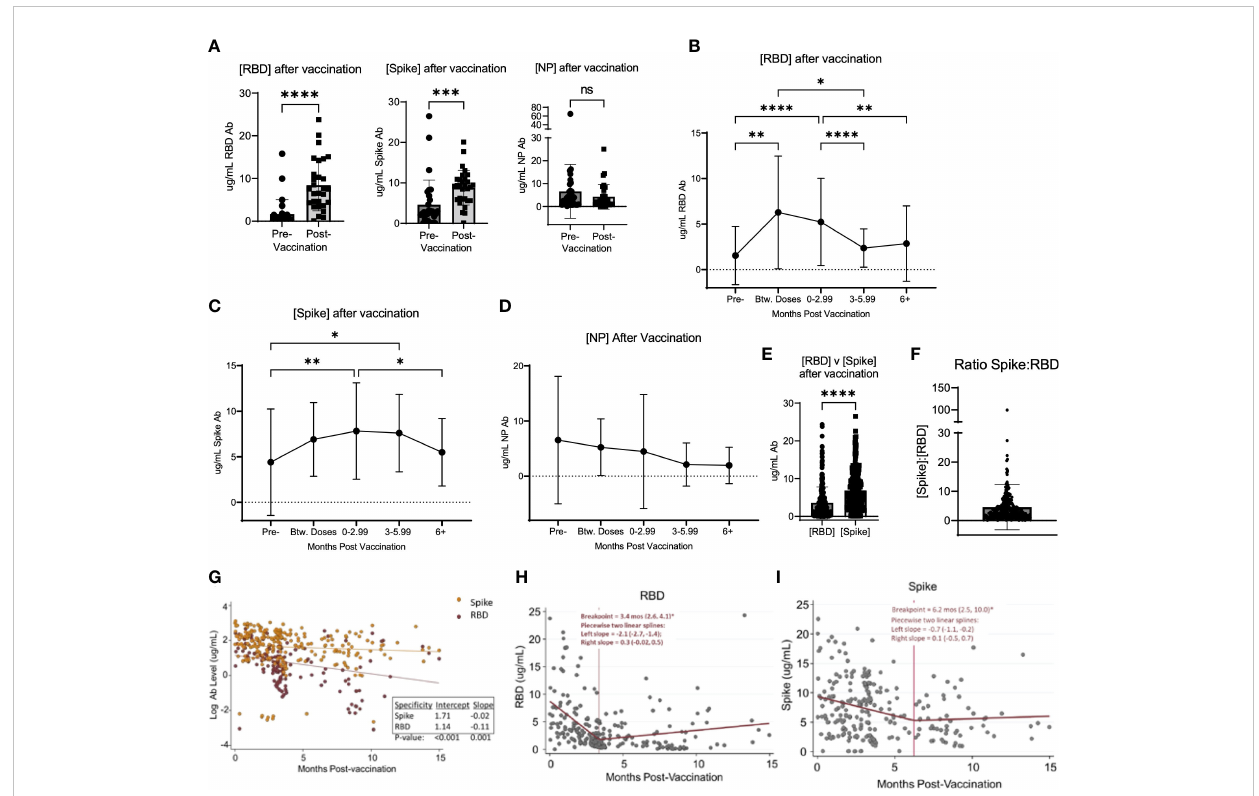
FIGURE 2 Vaccination induced changed in serological response to SARS-CoV-2. (A) shows the change in the concentration of RBD, Spike, and NP in participants who were vaccinated over the course of the study. (B) shows the change in RBD, Spike (C) , and NP (D) concentration after vaccination in all participants, regardless of when participants were vaccinated and when their blood was collected after vaccination. (E) shows the value of [RBD] and [Spike] in all participants after vaccination. (F) shows the ratio of the concentration of RBD to Spike for all participants after vaccination. (G) shows the log- transformed RBD (red data points) and Spike (orange data points) concentrations (i.e., to be consistent with exponential decay) over time using a GLS regression model (H) The lines represent the decay lines. Panel (H) shows the plot generated from piecewise linear regression models for the RBD protein or Spike protein (I) . The vertical line represents the “ breakpoint ” , which is the estimate of when the two linear phases of raw decay change. The two decay phases are shown before and after each breakpoint. The breakpoint and decay slopes for the left and right portion are noted in the graphs. * designates P >0.05, ** designates P >0.01, *** designates P >0.001, and **** designates P >0.0001. ns, not signi fi